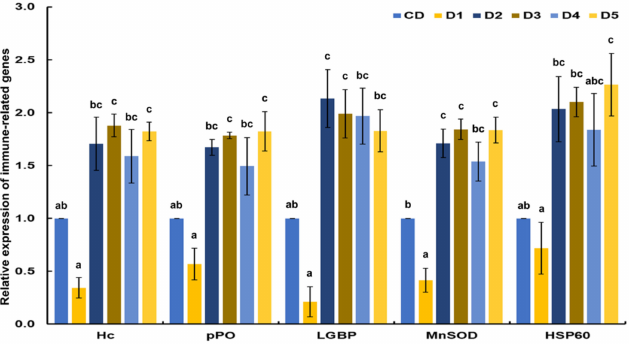
Figure 2. Transcriptional response of immune-related genes of shrimp fed control diet and 50% fishmeal replacement diets. ( A ) hemocyanin (Hc), ( B ) prophenoloxidase (pPO), ( C ) lipopolysaccharide- and β -glucan-binding protein (LGBP), ( D ) cytosolic manganese superoxide dismutase (MnSOD), and ( E ) heat shock protein 60 (HSP60). Data are presented as mean ± SE, values with different letters are significantly different ( p < 0.05). Abbreviations: CD (200 g/Kg FM), D1 (0.13% DL-MET), D2 (0.06% MET-MET), D3 (0.19% MET-MET), D4 (0.13% DL-MET plus 0.10% B. amyloliquefaciens CECT 5940) and D5 (0.06% MET-MET plus 0.10% B. amyloliquefaciens CECT